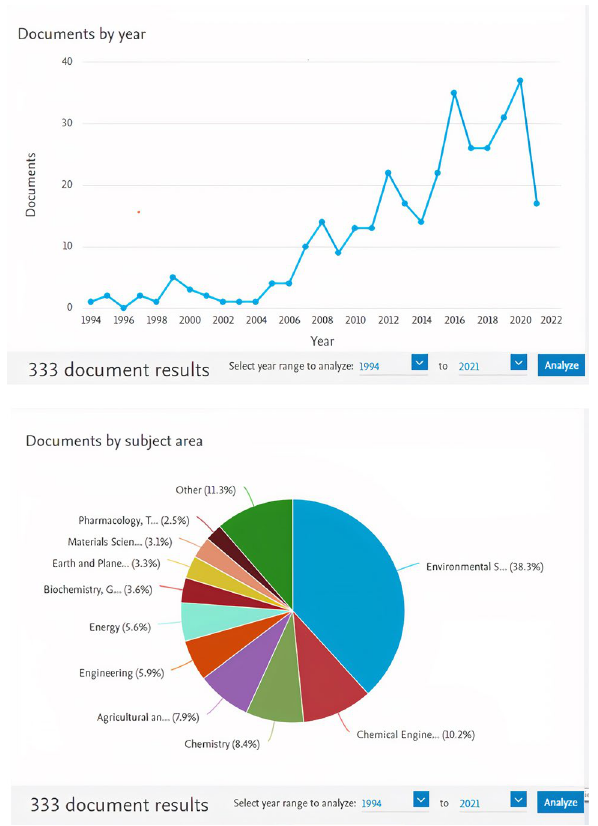
Fig. 1 Results extracted from Scopus